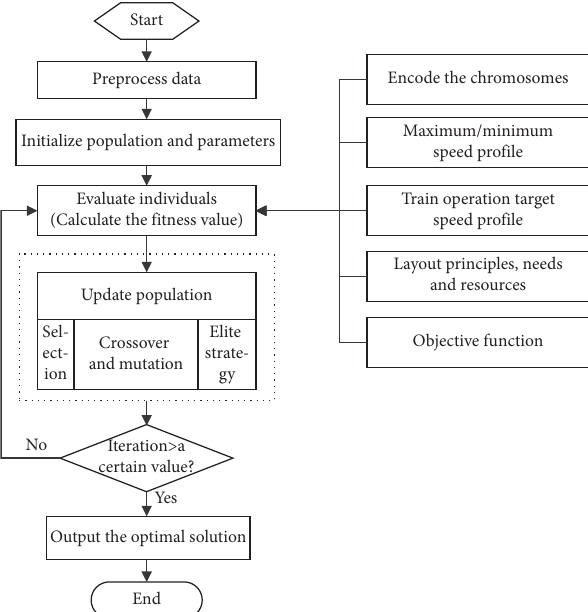
Figure 3: The simplified flowchart of solving